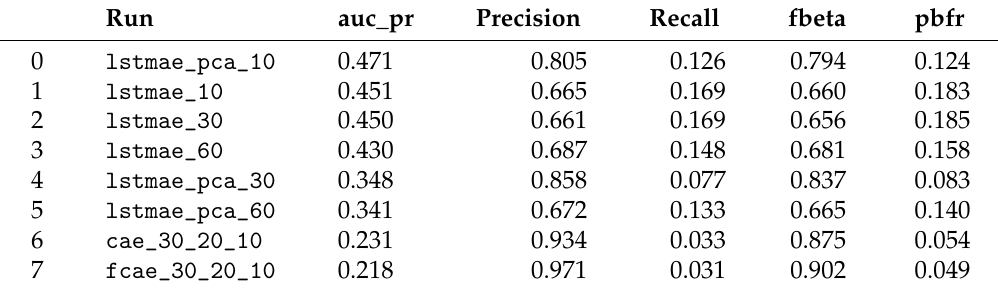
Table 8. Performance